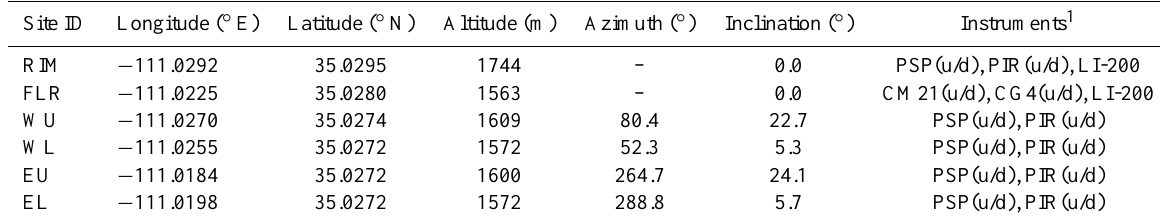
Table 1. Radiation measurement sites and their characteristics.